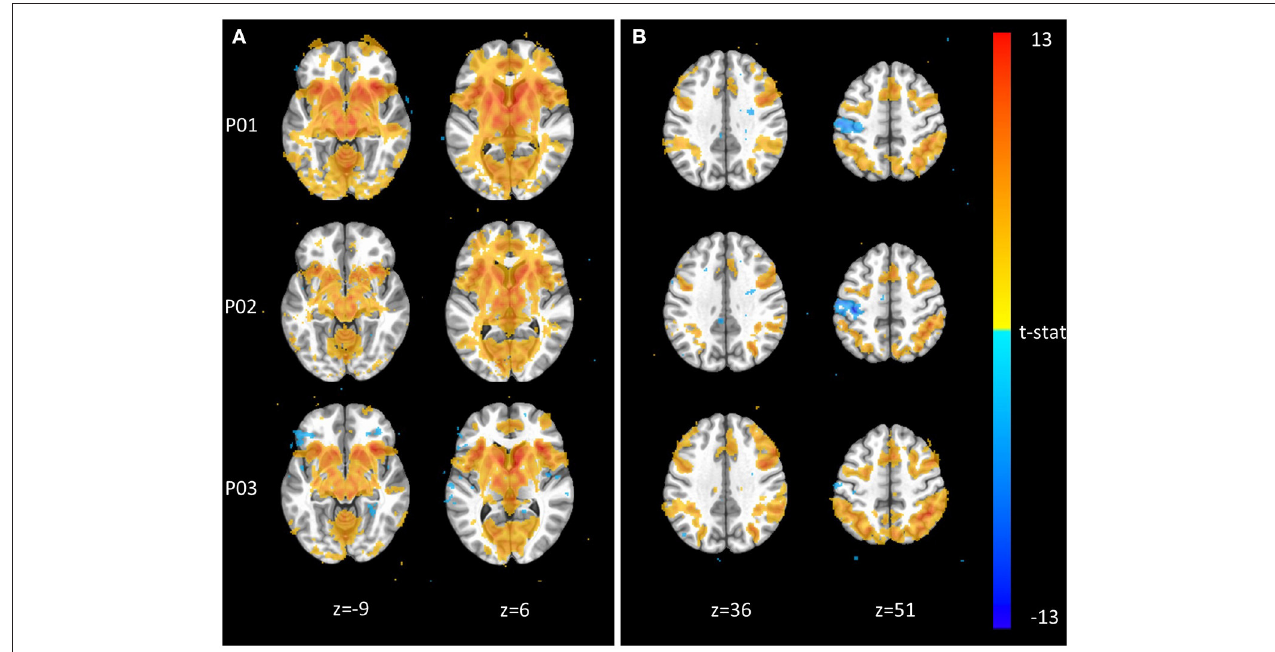
FIGURE 3 | Exemplar voxel-wise task activation maps produced by three different pipelines. (A) Monetary Incentive Delay P5–P0 contrast from n = 93 participants at p < 0.001. (B) Stop Signal Stop–NoStop contrast from n = 49 subjects at p <